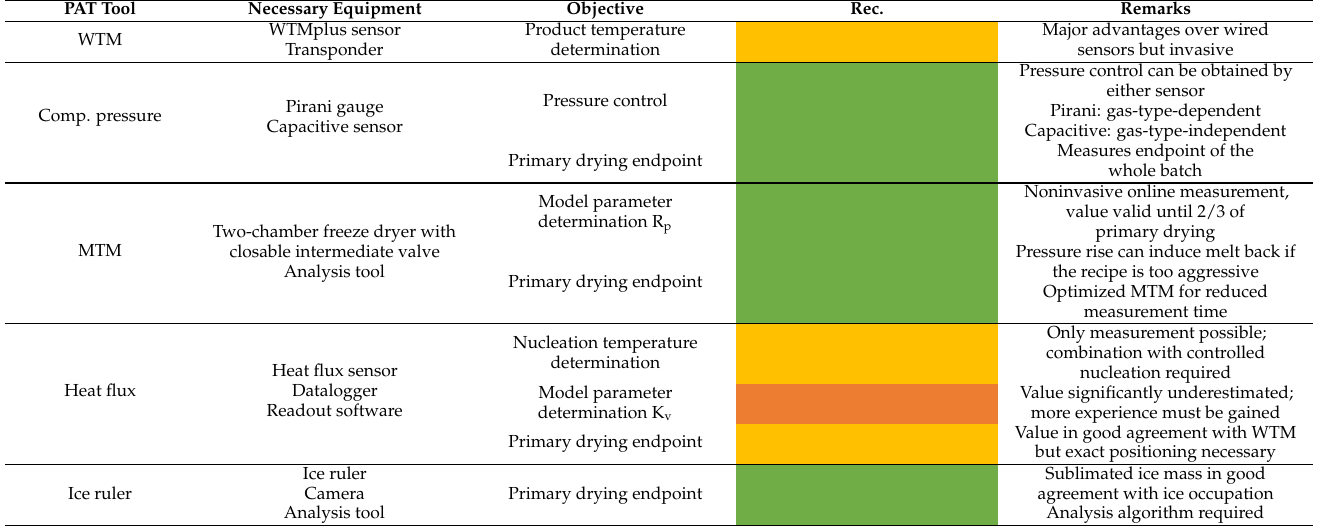
Table 5. PAT tools and their recommendation for usage in process control (green—fully recommended, yellow—limited recommendation, and orange—more experience